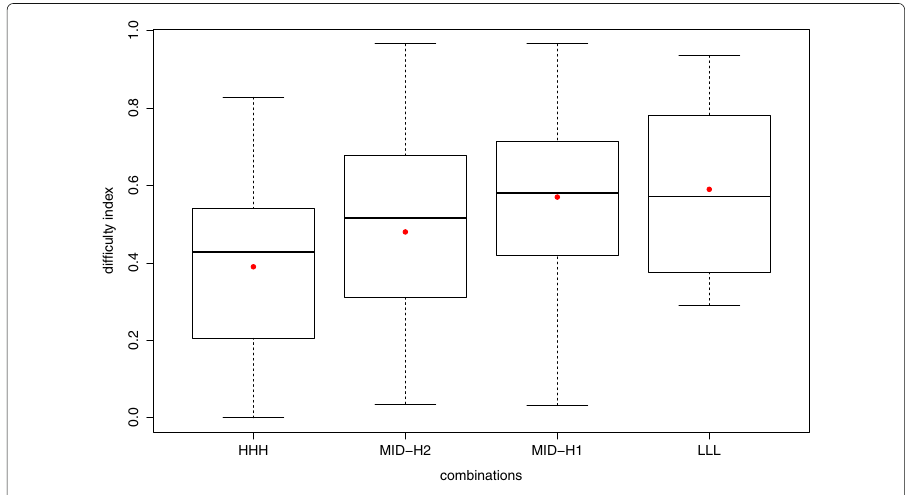
Fig. 3 Box plot for four regrouped